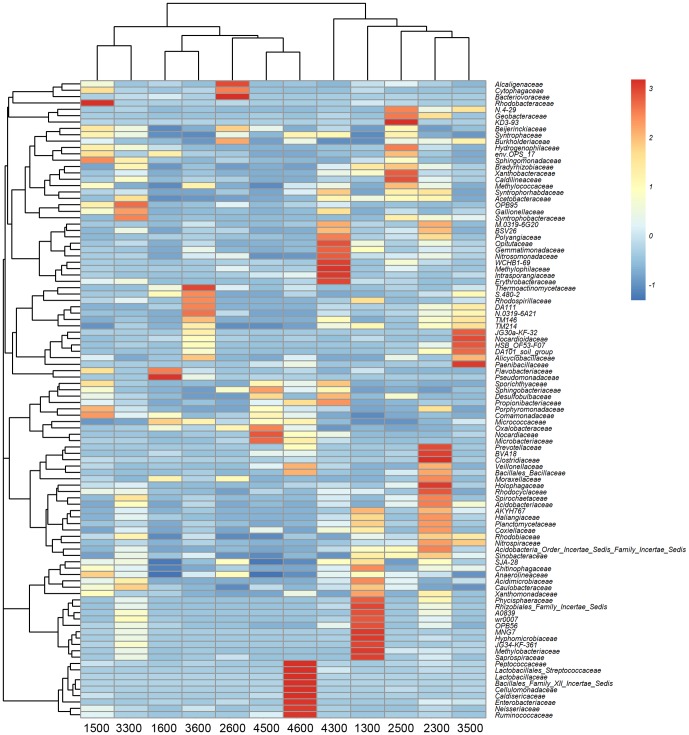
Bacterial distribution of the top 100 abundant families among the twelve samples.Double hierarchical dendrogram shows the bacterial distribution. The bacterial phylogenetic tree was calculated using the neighbor-joining method and the relationship among samples was determined by Bray-Curtis distance and the complete clustering method. The heatmap plot depicts the relative percentage of each bacterial family (variables clustering on the vertical-axis) within each sample (horizon-axis clustering). The relative values for bacterial family are indicated by color intensity with the legend indicated at the top right corner.